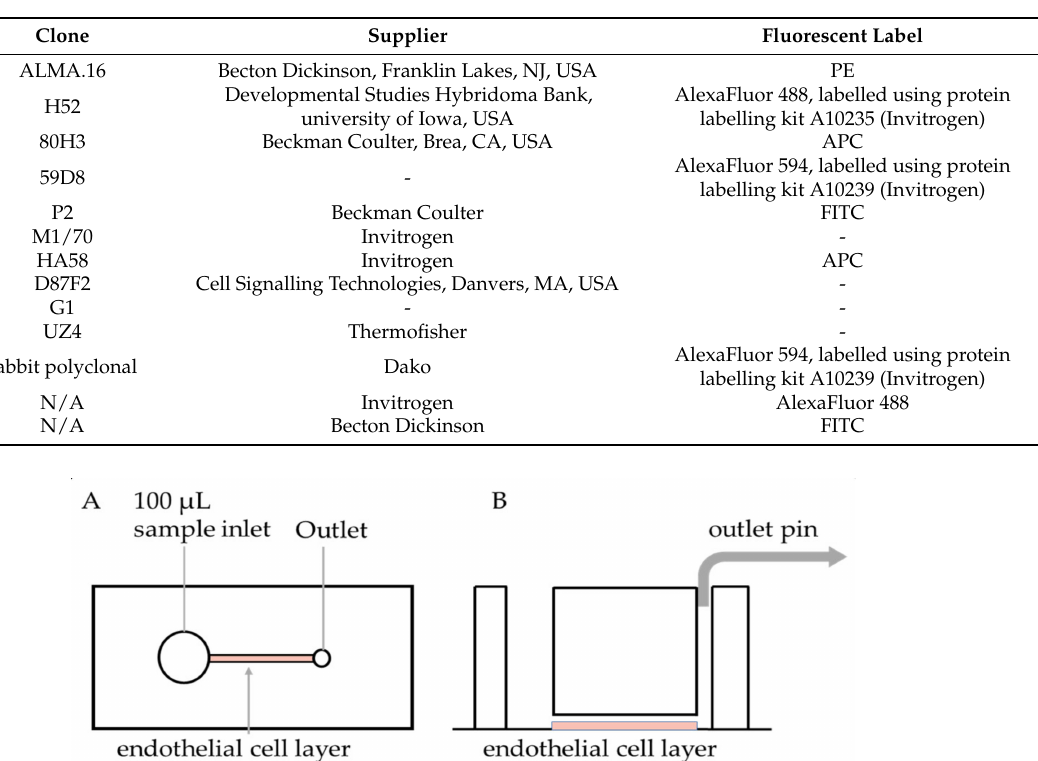
Table 2. Antibodies used for the study of thromboinflammation in this study.